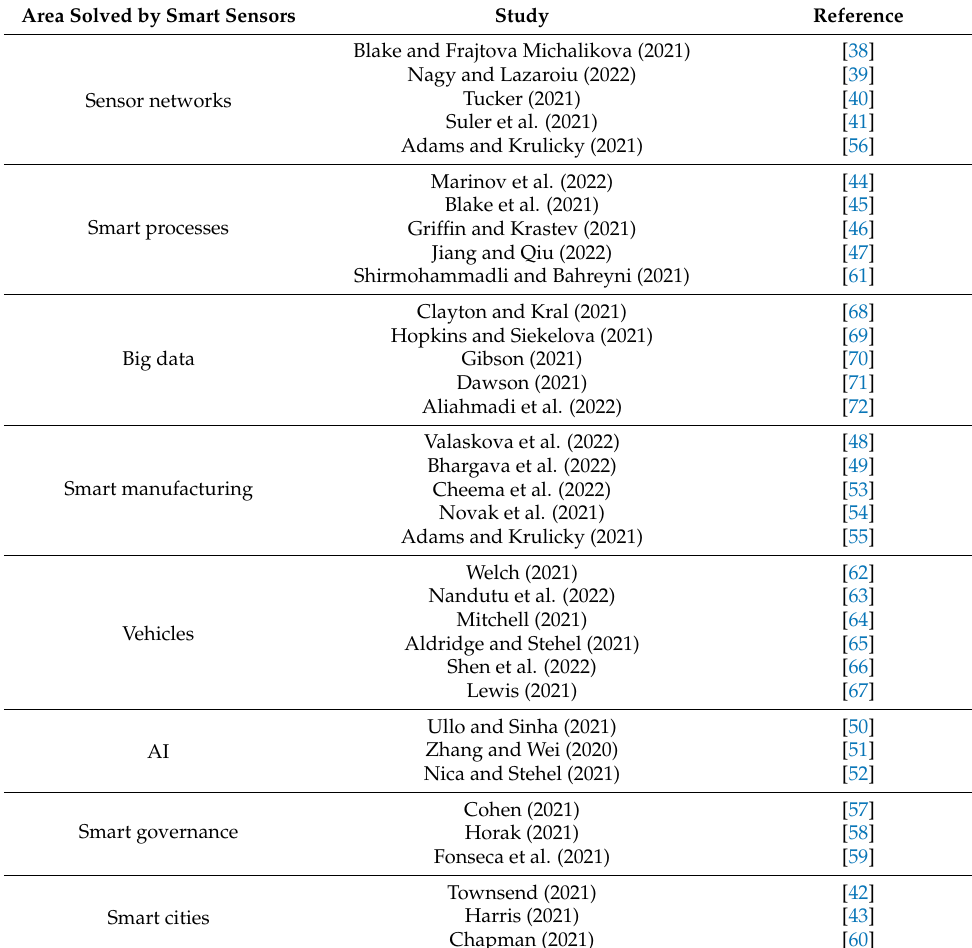
Table 1. Summary of last incentives from literature